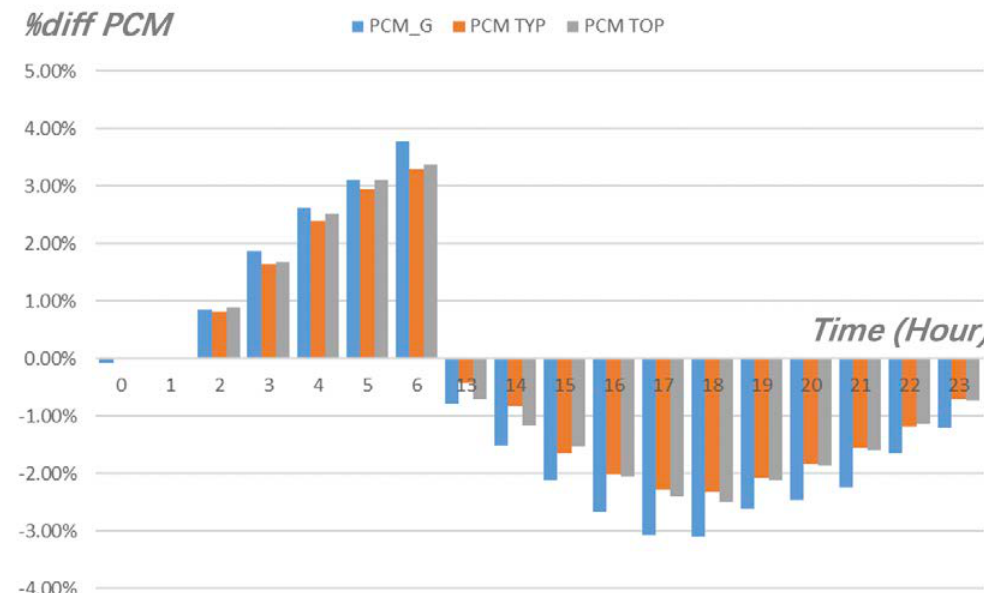
Figure 4. Hourly median for energy performance on di ff erent floors presented in percentage di ff erence from benchmark after applying PCM. Note: PCM_G —the di ff erence for ground floor; PCM_TYP —the di ff erence for typical floor; PCM_TOP —the di ff erence for top floor.